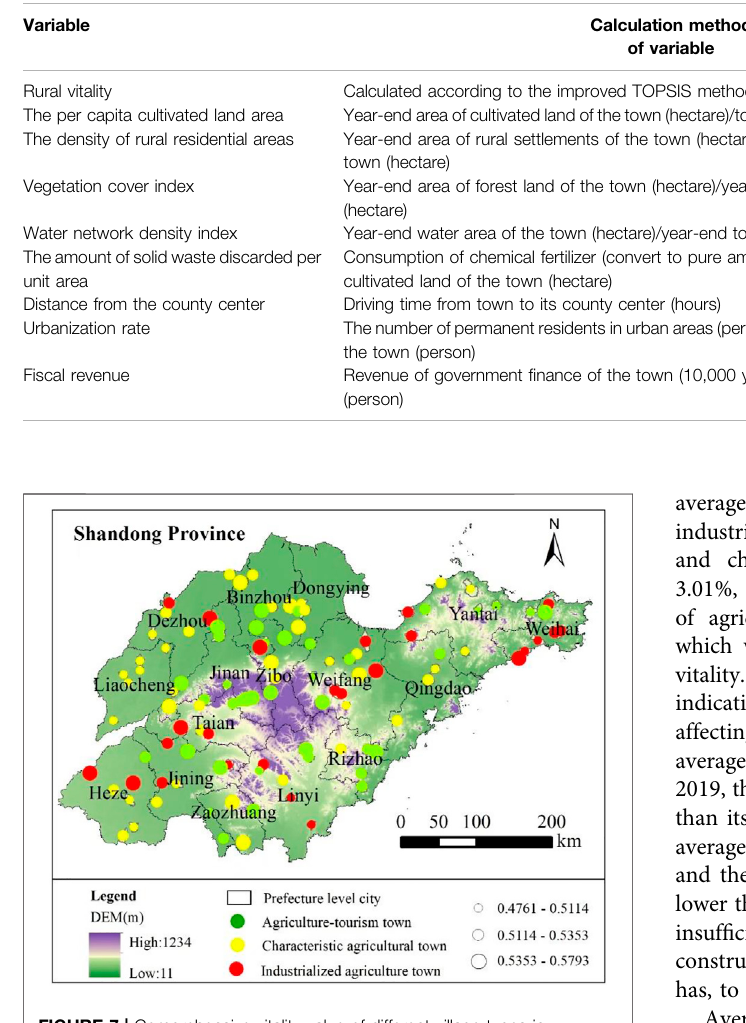
TABLE 2 | Variable de fi nition and descriptive statistics.